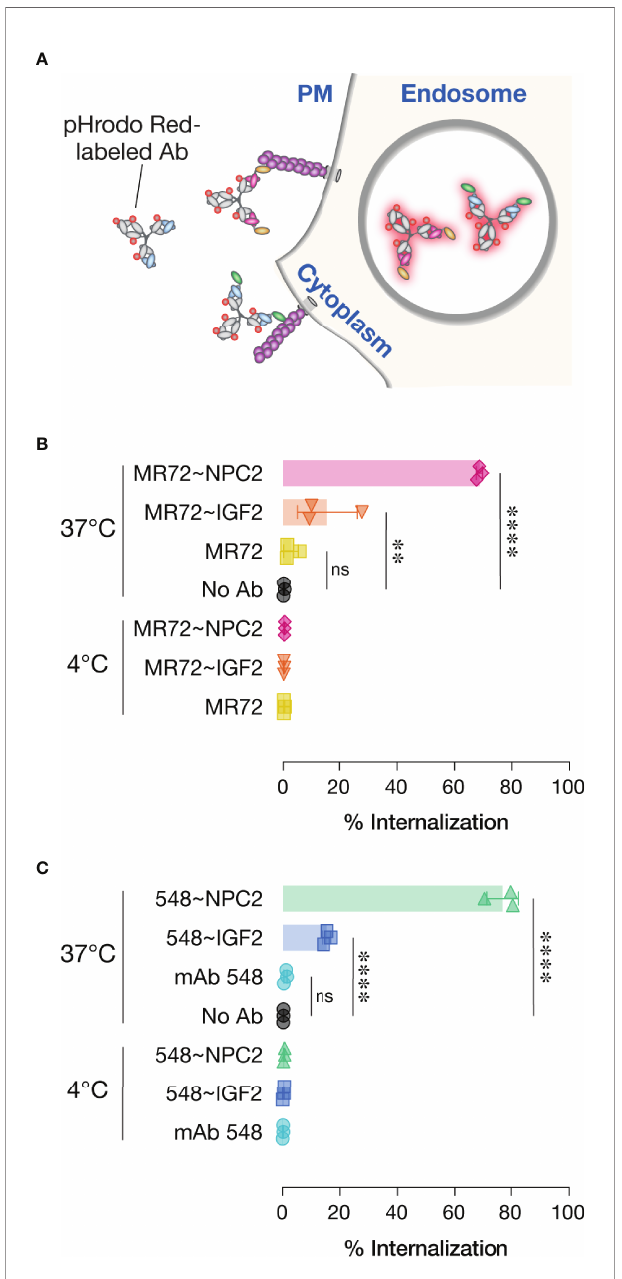
FIGURE 6 | Cellular internalization of Trojan horse bsAbs. (A) Schematic of pHrodo Red-labeled antibody internalization experiment. (B, C) Labeled antibodies were incubated with cells at either 4°C to prevent internalization or 37°C to allow internalization prior to analysis by fl ow cytometry. Data points represent the percentage of pHrodo Red positive cells; bars represent means ± SD from 3 independent experiments. Group means (bars) were compared using one-way ANOVA with Turkey ’ s multiple comparisons test. (****P < 0.0001; **P < 0.01; ns, not signi fi cant).